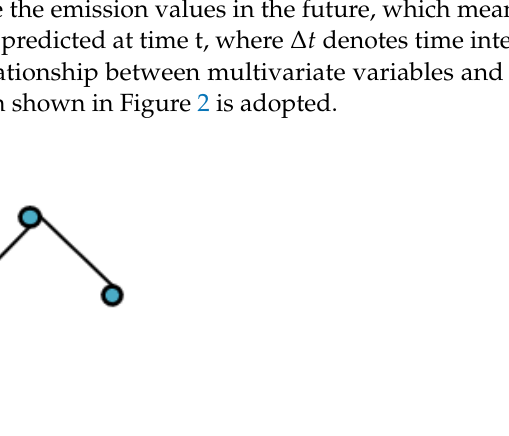
Figure 2. Multivariate graph structure in which each node can be connected to every other.